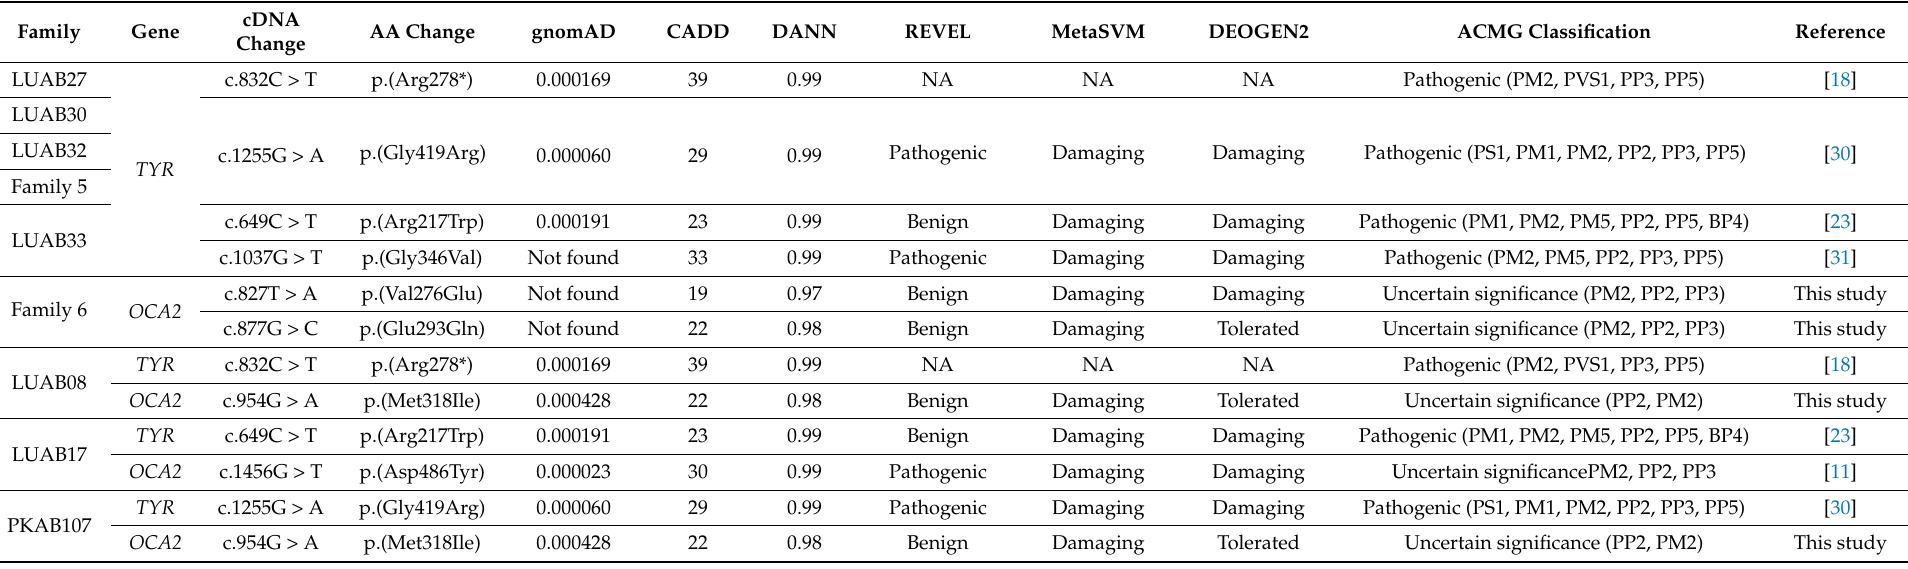
Table 2. List of genetic variants found in Pakistani OCA